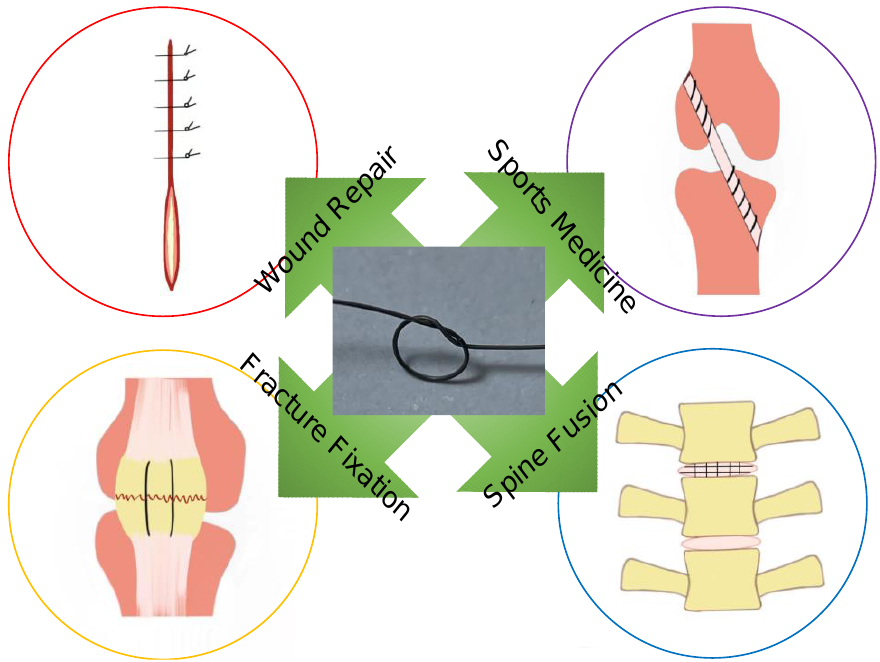
Figure 6. Clinical translation of Mg-Zn-Gd wire.